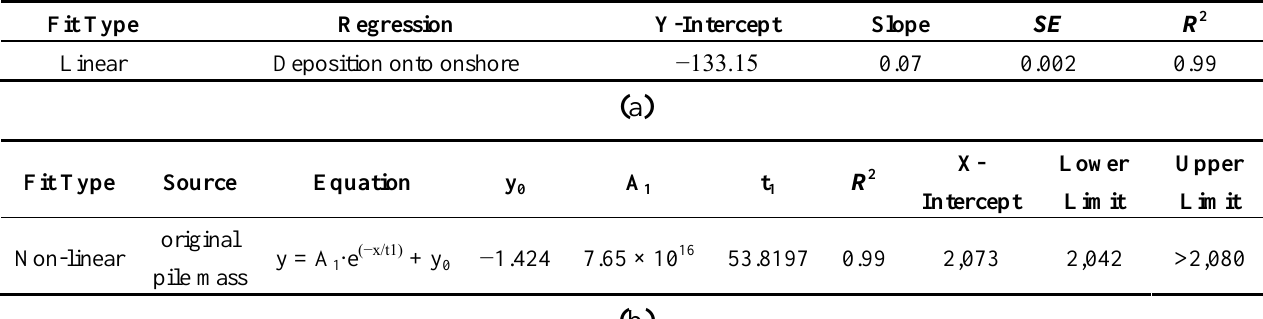
Table 2. Regression values for ( a ) stamp sands deposition onto onshore beach locations and ( b ) erosion off the original